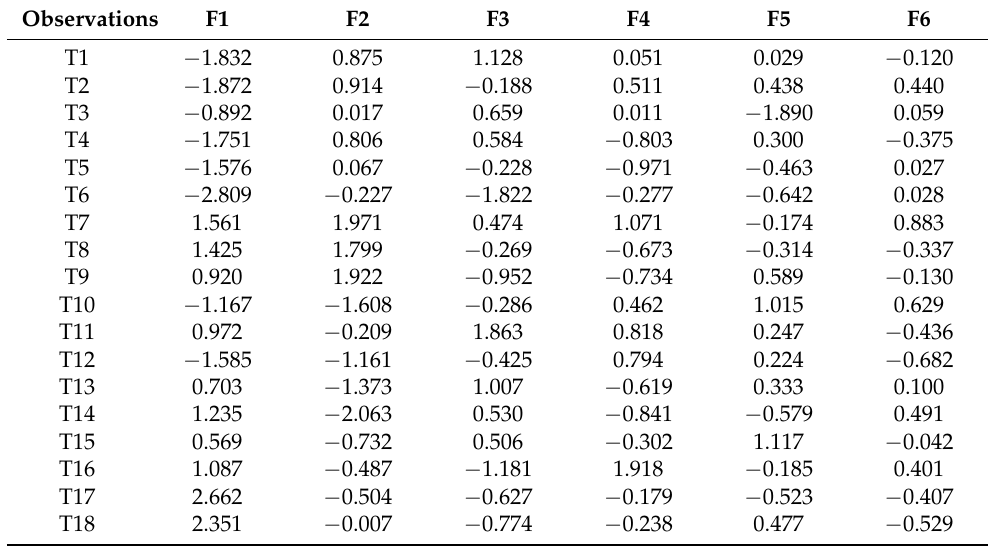
Table 10. Factor scores of the observations (T1 . . . T18) for TSS , COD , and FM versus PCs (F1 . . . F6). Observations